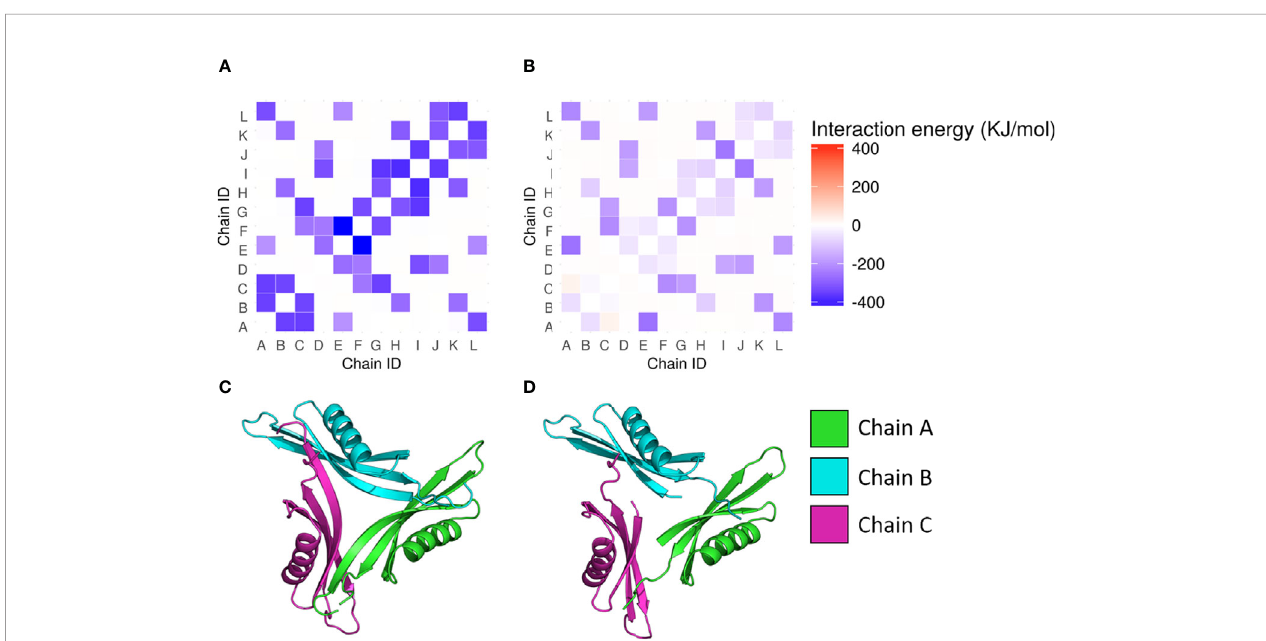
FIGURE 4 | Interchain interaction energy in the dodecamers. The heatmaps in (A, B) show respectively the interaction energies between the protein chains in the M.tb and the BCG Moreau dodecamers; the energy is depicted as a color scale and the 12 chains of each dodecamer are identi fi ed from A to L in both axes. The bottom images (C, D) depict one of the faces of the dodecamer of M.tb dodecin and BCG Moreau,